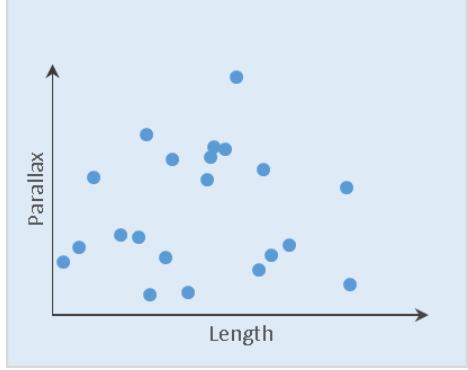
Fig. 2 Relationship between actual parallax and segment